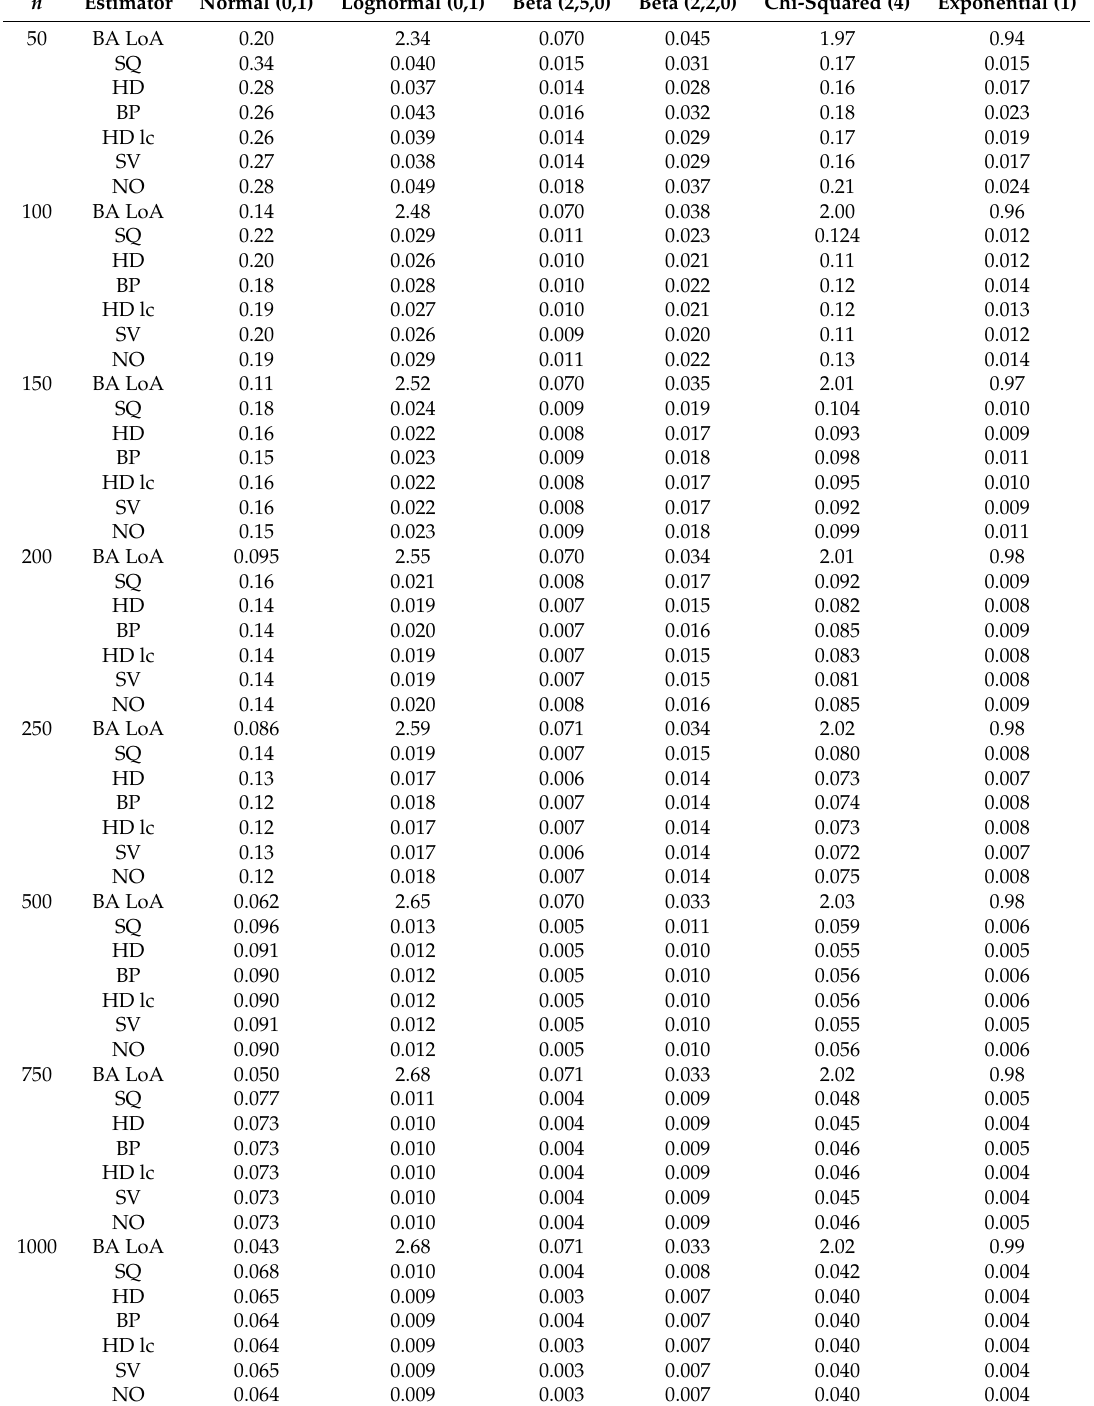
Table 2. RMSE of the estimated 2.5% quantiles by sample size, estimator, and